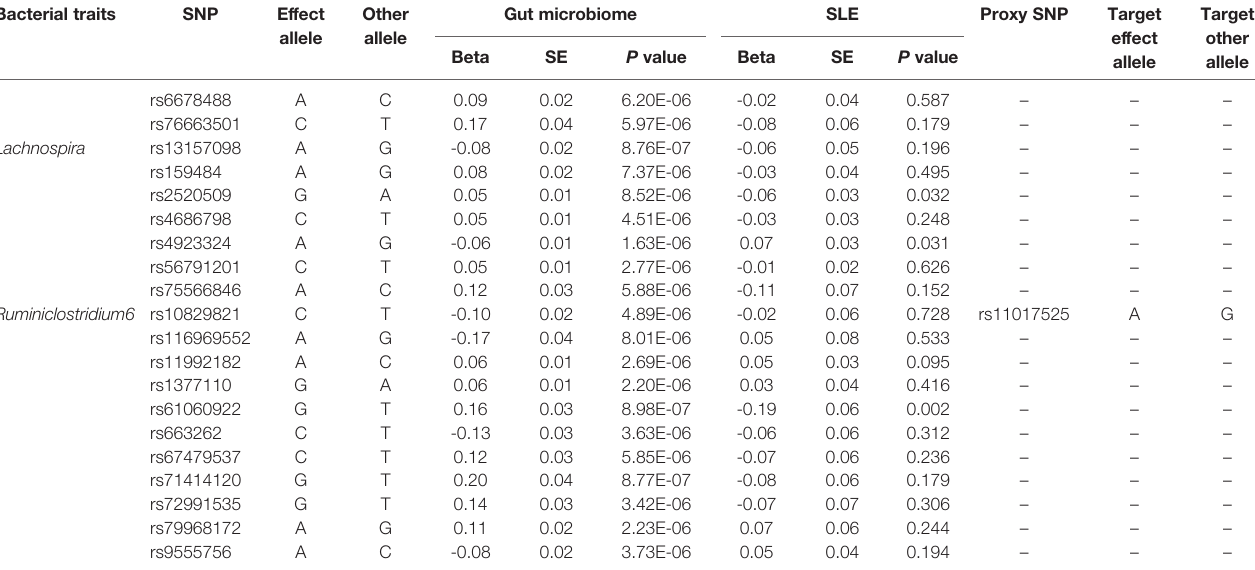
( Table 3 ). Heterogeneity and horizontal pleiotropy could not be examined due to the limited number of included